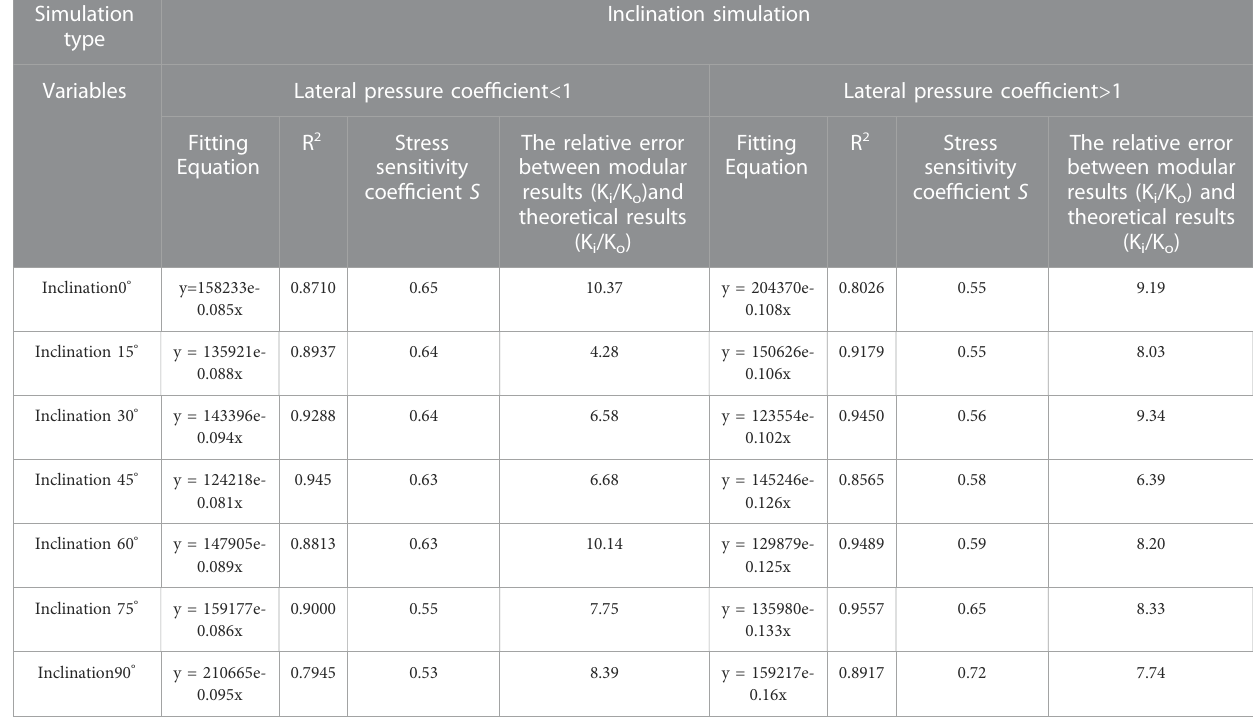
TABLE 3 The related parameters of numerical simulation and the theoretical calculation